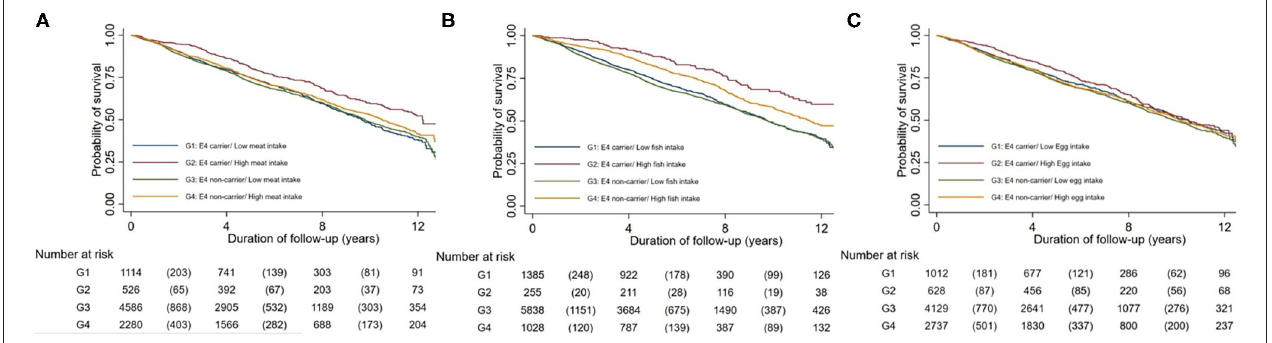
FIGURE 1 | Kaplan-Meier estimates of survival by a joint classification of the APOE c4 genotype and meat intake (Graph A ), fish intake (Graph B ), and egg intake (Graph C ).